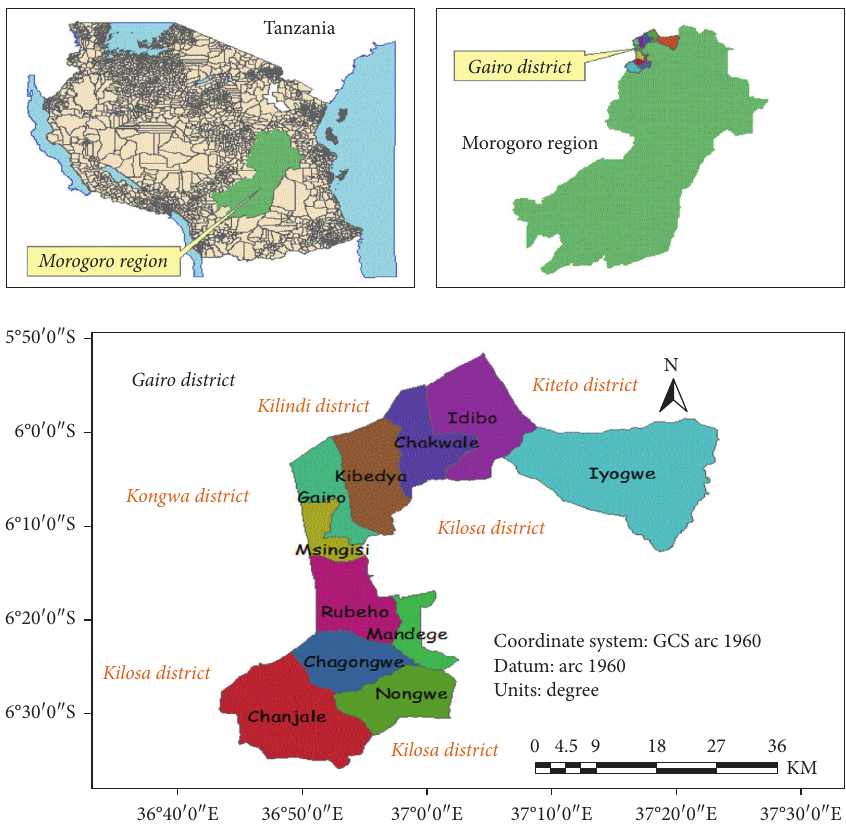
Figure 1: A map of Gairo